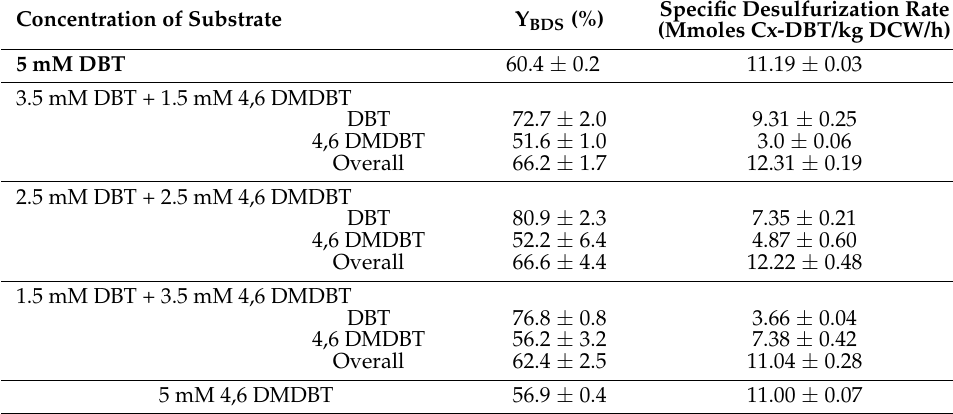
Table 4. Υ BDS and specific desulfurization rates of R. erythropolis IGTS8 resting cells on DBT, 4,6- DMDBT, and the mixture of DBT + 4,6-DMDBT in the biphasic system. Concentration of